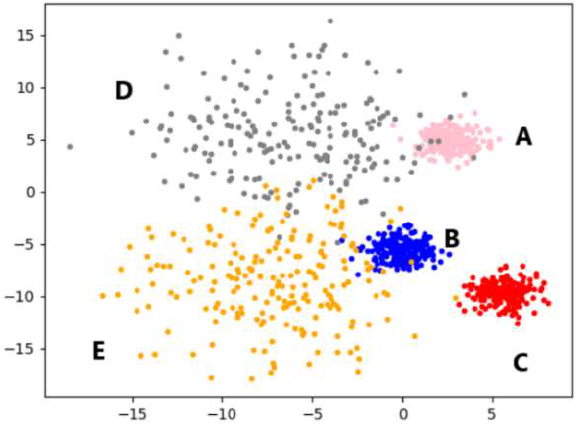
Figure 8. Multi-density dataset ( n = 1000, C = 5).